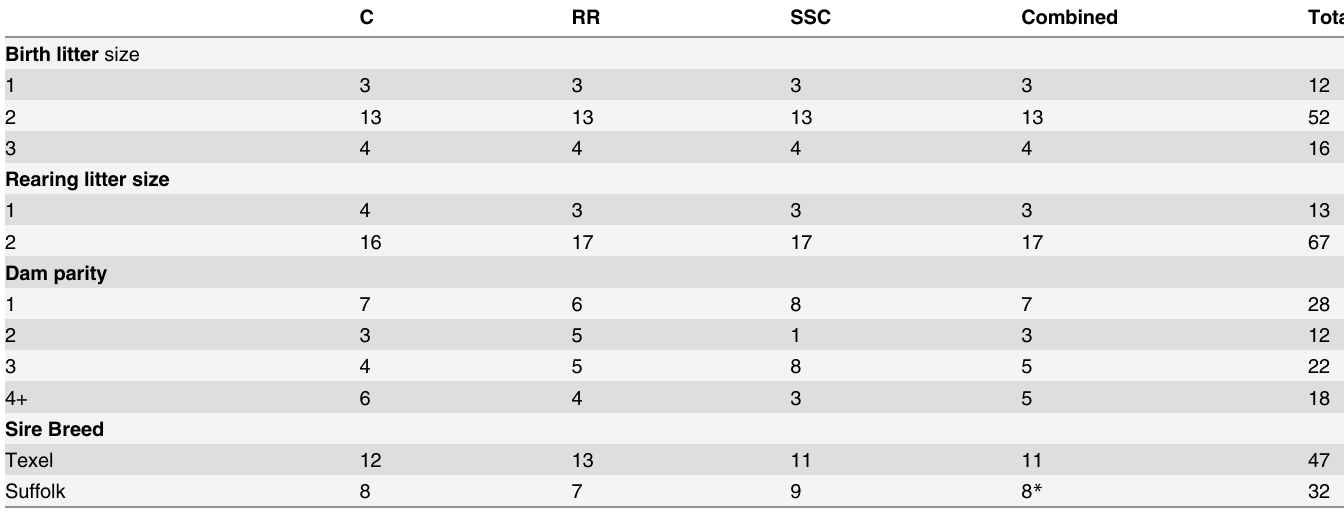
Table 1. Distribution of lambs by birth and rearing litter size, dam parity and sire breed between treatment